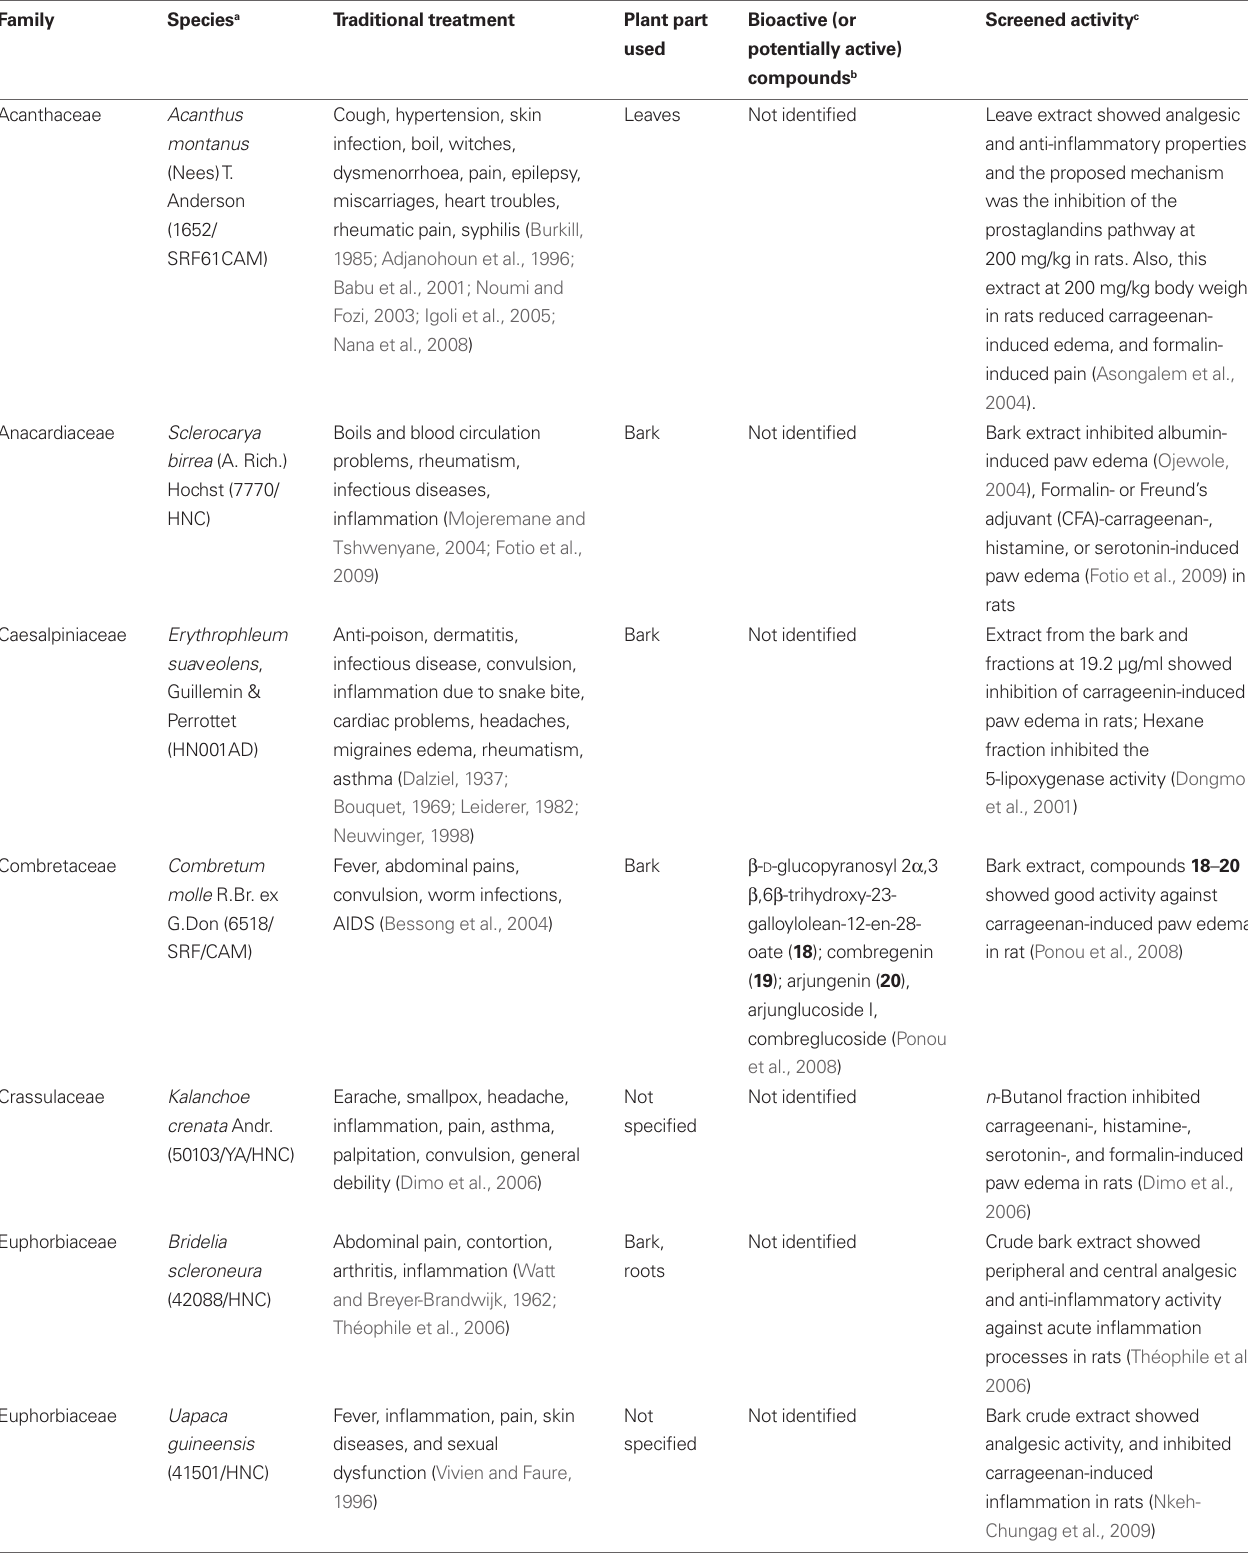
Table 4 | Plants used in Cameroon as anti-inflammatory and analgesic agents, with evidence of their